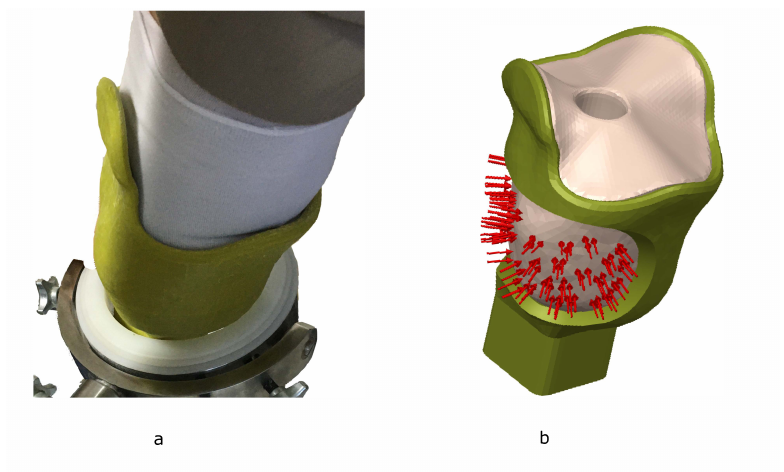
Figure 1. Interface pressure (IP) between lower limb residuum and socket. ( a ) 3D printed socket being tested by an amputee in an aluminum support block. ( b ) Cutout 3D model showing the pressure exerted by the prosthetic socket over the interface area of the residual